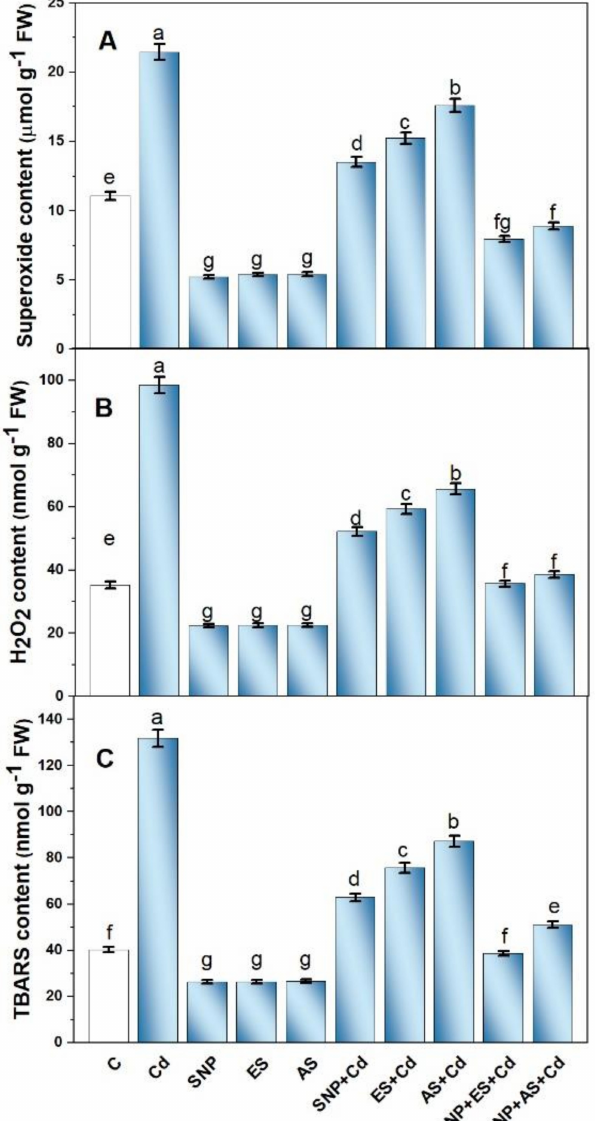
Figure 2. Superoxide content ( A ), H 2 O 2 content ( B ), and TBARS content ( C ) in mustard ( Brassica juncea L. cv. Giriraj) treated with 100 µ M SNP (NO donor) and 200 mg S kg − 1 soil of elemental sulfur (ES) or ammonium sulfate (AS) in the presence or absence of 200 mg Cd kg − 1 soil at 30 days after sowing. Data are presented as treatment mean ± SE (n = 4). Data followed by the same letter are not significantly different as determined by LSD test at p < 0.05. C, control; Cd, cadmium; cv., cultivar; FW, fresh weight; H 2 O 2 , hydrogen peroxide; SNP, sodium nitroprusside; TBARS, thiobarbituric acid reactive